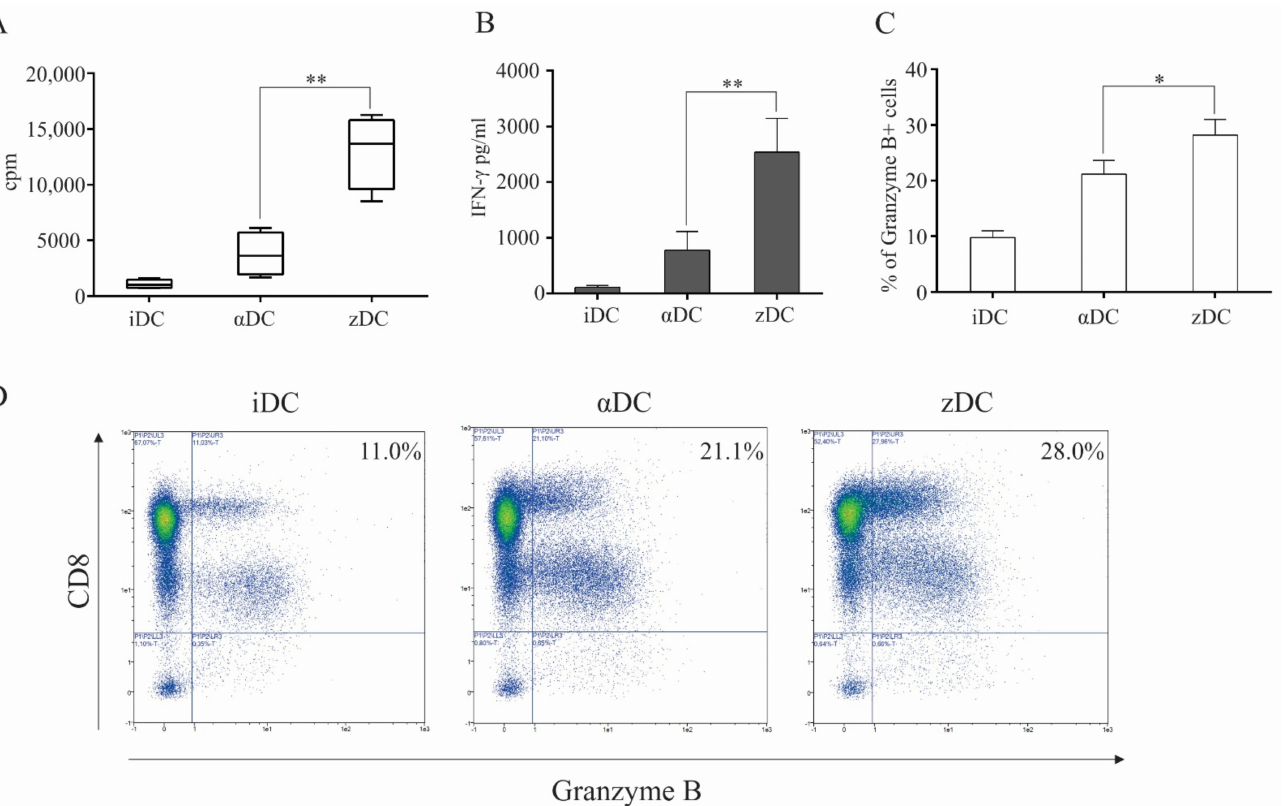
Figure 5. zDCs have an exceptional capacity to induce cytotoxic T cell responses. ( A ) iDCs, α DCs, or zDCs were used in co-cultures with whole, allogeneic CD8+ T cells. They were placed in 96-well tissue plates, with a 1:10 DC:T cell ratio. On day 4, the wells were pulsed with 1 µ Ci/well of 3H- thymidine. On day 5, cell proliferation was measured using liquid scintillation counting. Results show mean ± SD of four independent experiments (cpm, counts per minute). ( B ) In parallel co- cultures with allogeneic CD8+ T cells and variously treated DCs, after 5 days, levels of IFN- γ were analyzed in culture supernatants. Bar graphs represent mean ± SD of four independent experiments. Statistical comparison between individual samples was performed using Student’s t test. A p value of less than 0.05 was considered statistically significant (**— p < 0.01). ( C , D ) Cytotoxic T cell activation was measured by detection of intracellular granzyme B expression. iDCs, α DCs, or zDCs were used as stimulators of allogeneic CD8+ T cells. The co-cultures were performed in 48-well tissue plates in complete RPMI medium (10% human AB serum). After 5 days, the T cells were collected, washed, and stained for CD8 and granzyme B expression (intracellularly). Statistical comparison of individual pairs of three independent experiments was performed using Student’s t test (* p < 0.05). The numbers in upper right quadrants represent the percentage of granzyme B-positive CD8+ T